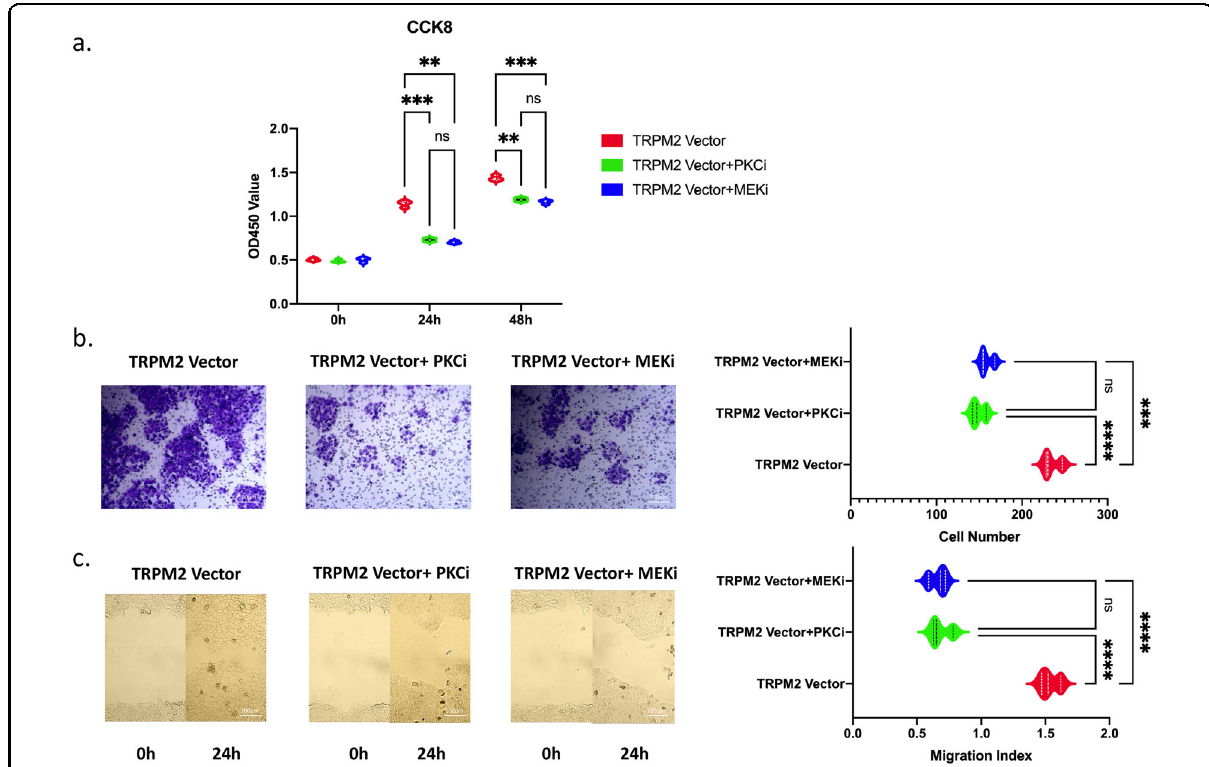
Fig. 7 Using PKC inhibitor sotrastraurin (PKCi) and raf-1 inhibitor sorafenib (MEKi) to test the proliferation, invasion, and migration abilities of TRPM2 overexpressed (TRPM2 Vector) BxPC-3 cells. a CCK8 results. b Transwell results. c Scratch wound-healing assay results. ** P < 0.01, *** P < 0.001 (three repeats for each group).